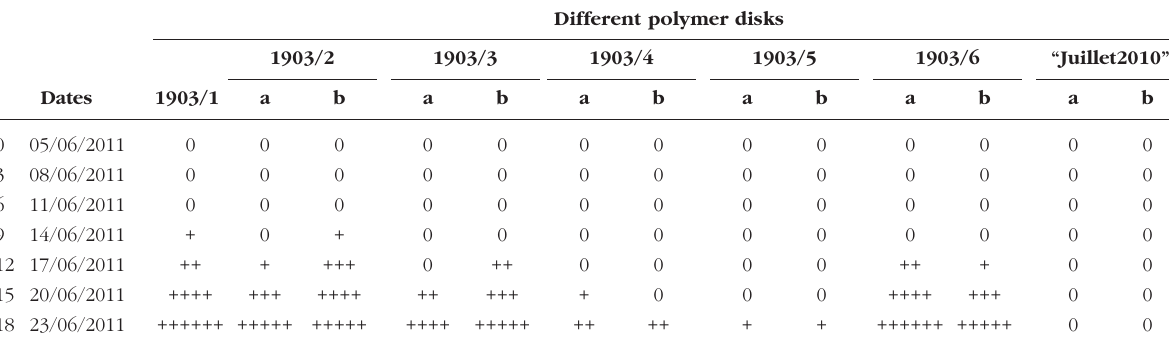
Table IV ter. – Experiment C: presence and abundance of Ae. albopictus larvae in saucers with different geraniol impregnated polymer disks in an infested area, two months after the previous test using the same